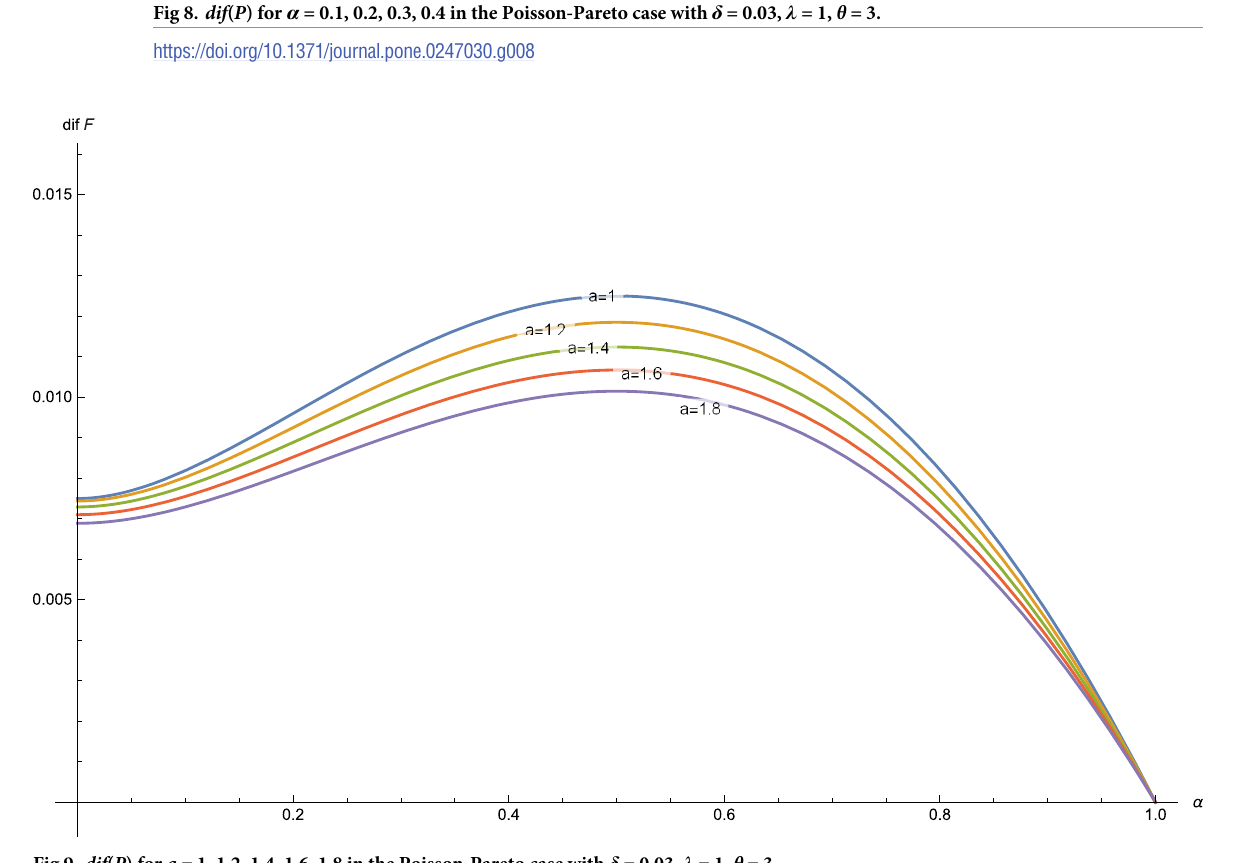
PLOS ONE | https://doi.org/10.1371/journal.pone.0247030 February 17,